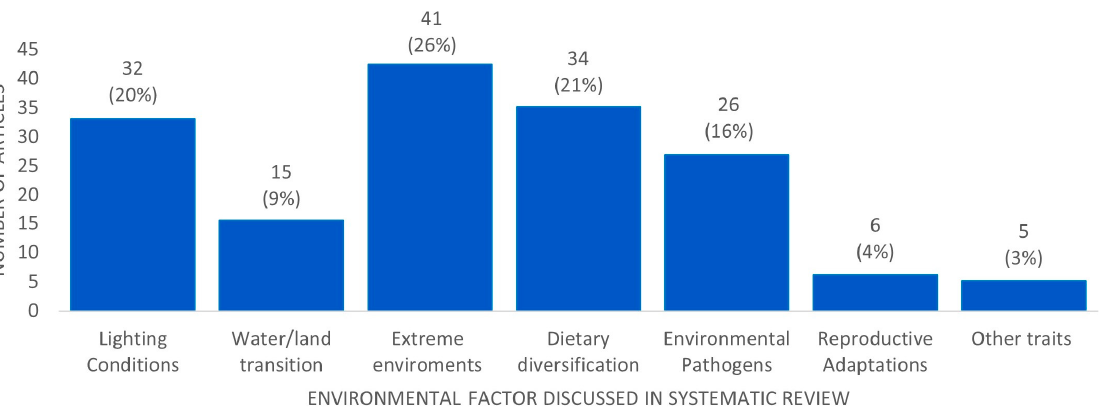
Figure 4. Division of articles by topic, as discussed in this systematic review. The 150 selected articles were grouped into six categories corresponding to the six discussed environmental factors and “other traits” pulled together. A total of 14 articles investigated or reviewed more than one of these environmental factors; consequently, 13 of these articles were discussed in two chapters, and the remaining article was discussed in three.